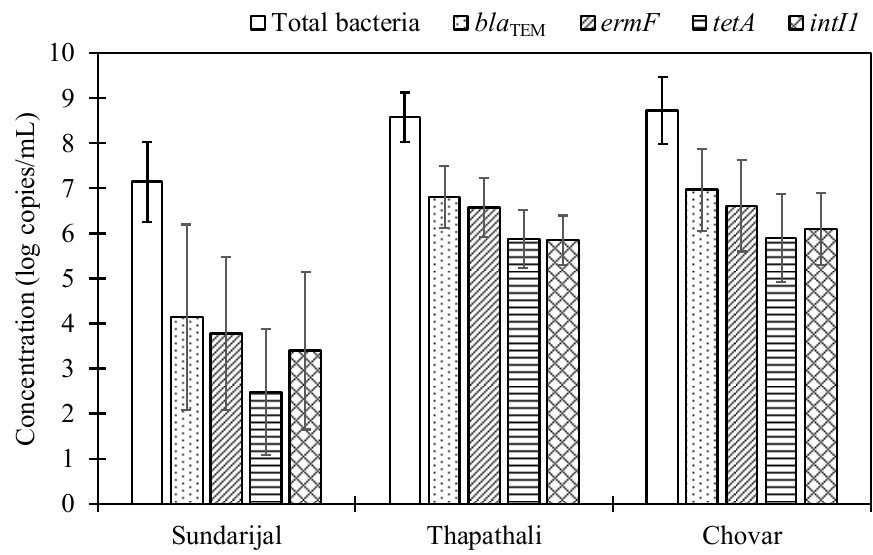
Figure 2. Concentrations of total bacteria, ARGs, and intI1 in the river water samples.